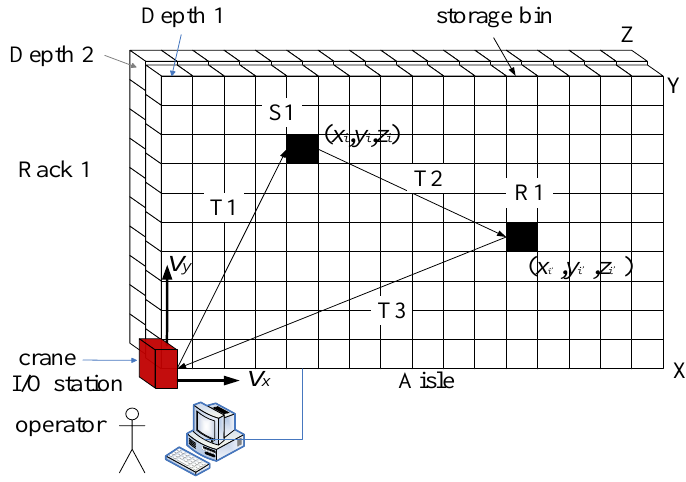
Figure 3. A unit-load and double-deep AS/RS.